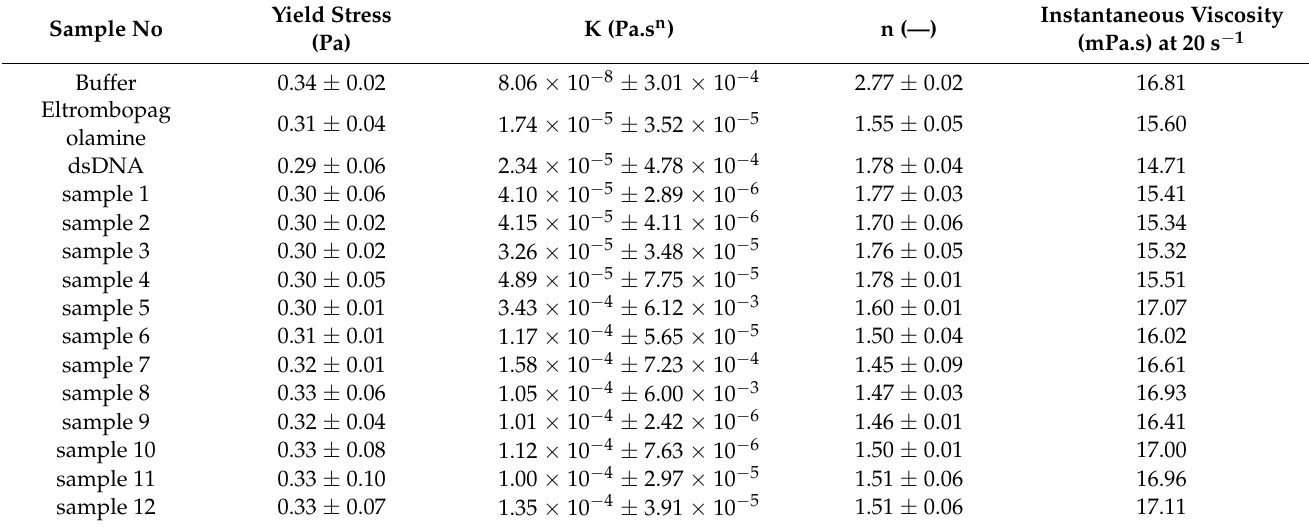
Table 3. The Herschel–Bulkey parameters and calculated instantaneous viscosities at 20 s − 1 .